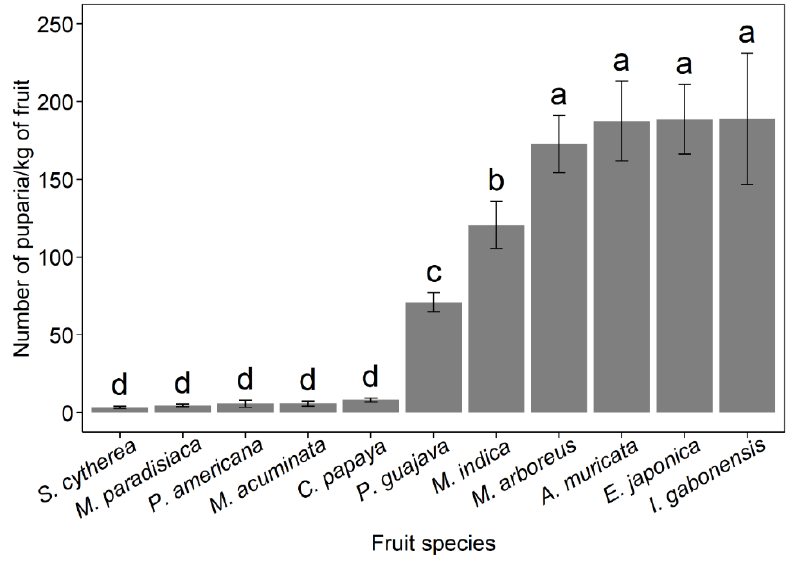
Figure 5. Mean infestation levels (mean number of puparia per kg of fruit ± SE) per fruit in HF-BR. Host fruit species followed by the same letter in the graph are not significantly different (GLM with Gaussian error, Tukey’s HSD, p < 0.05).